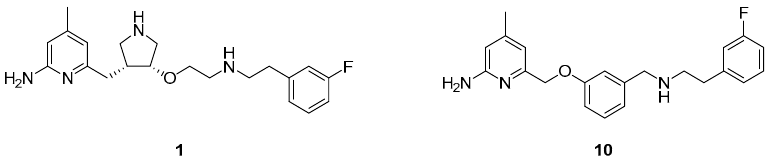
Figure 1. Novel NOS inhibitors: 6-(((3 R ,4 R )-4-(2-((3-fluorophenethyl)amino)ethoxy)pyrrolidin-3-yl)methyl)-4-methylpyridin-2-amine ( 1 ) [23] and 6-((3-(((3-fluorophenethyl)amino)methyl)phenoxy)methyl)-4-methylpyridin-2-amine ( 10 ) [25].